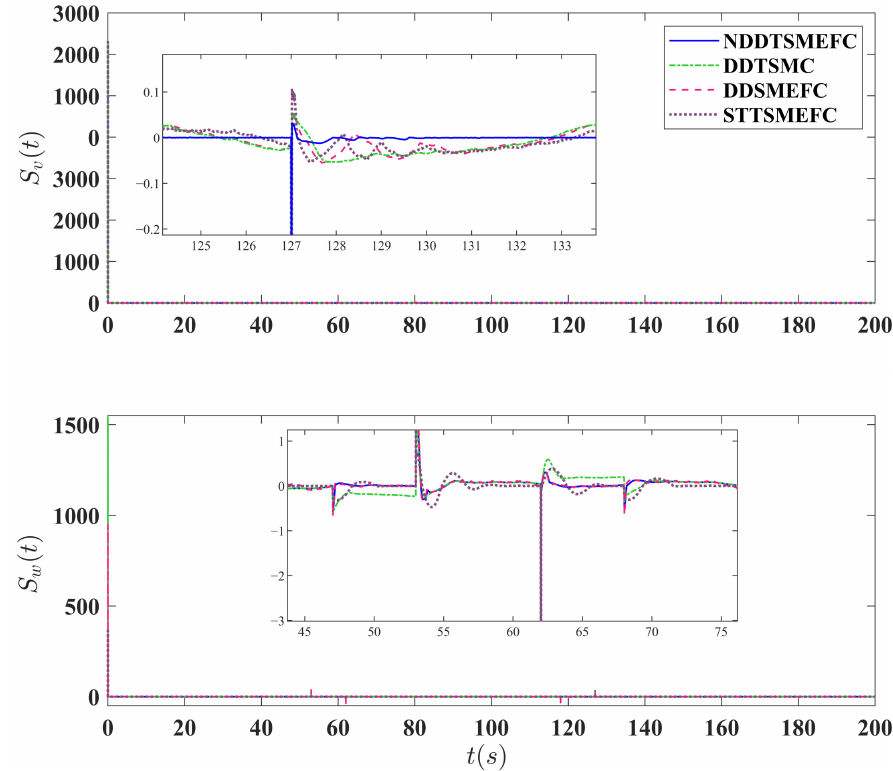
Figure 11. Schematic diagram of UROV sliding mode surface value.